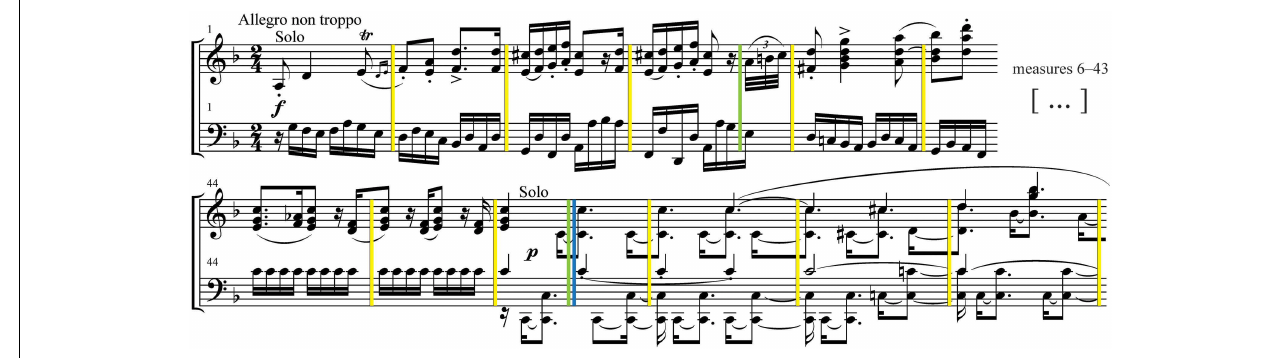
(yellow), phrases (green), and sections (blue). The digital audio recording was segmented at the corresponding time points, and then reassembled with the segments in randomly shuffled